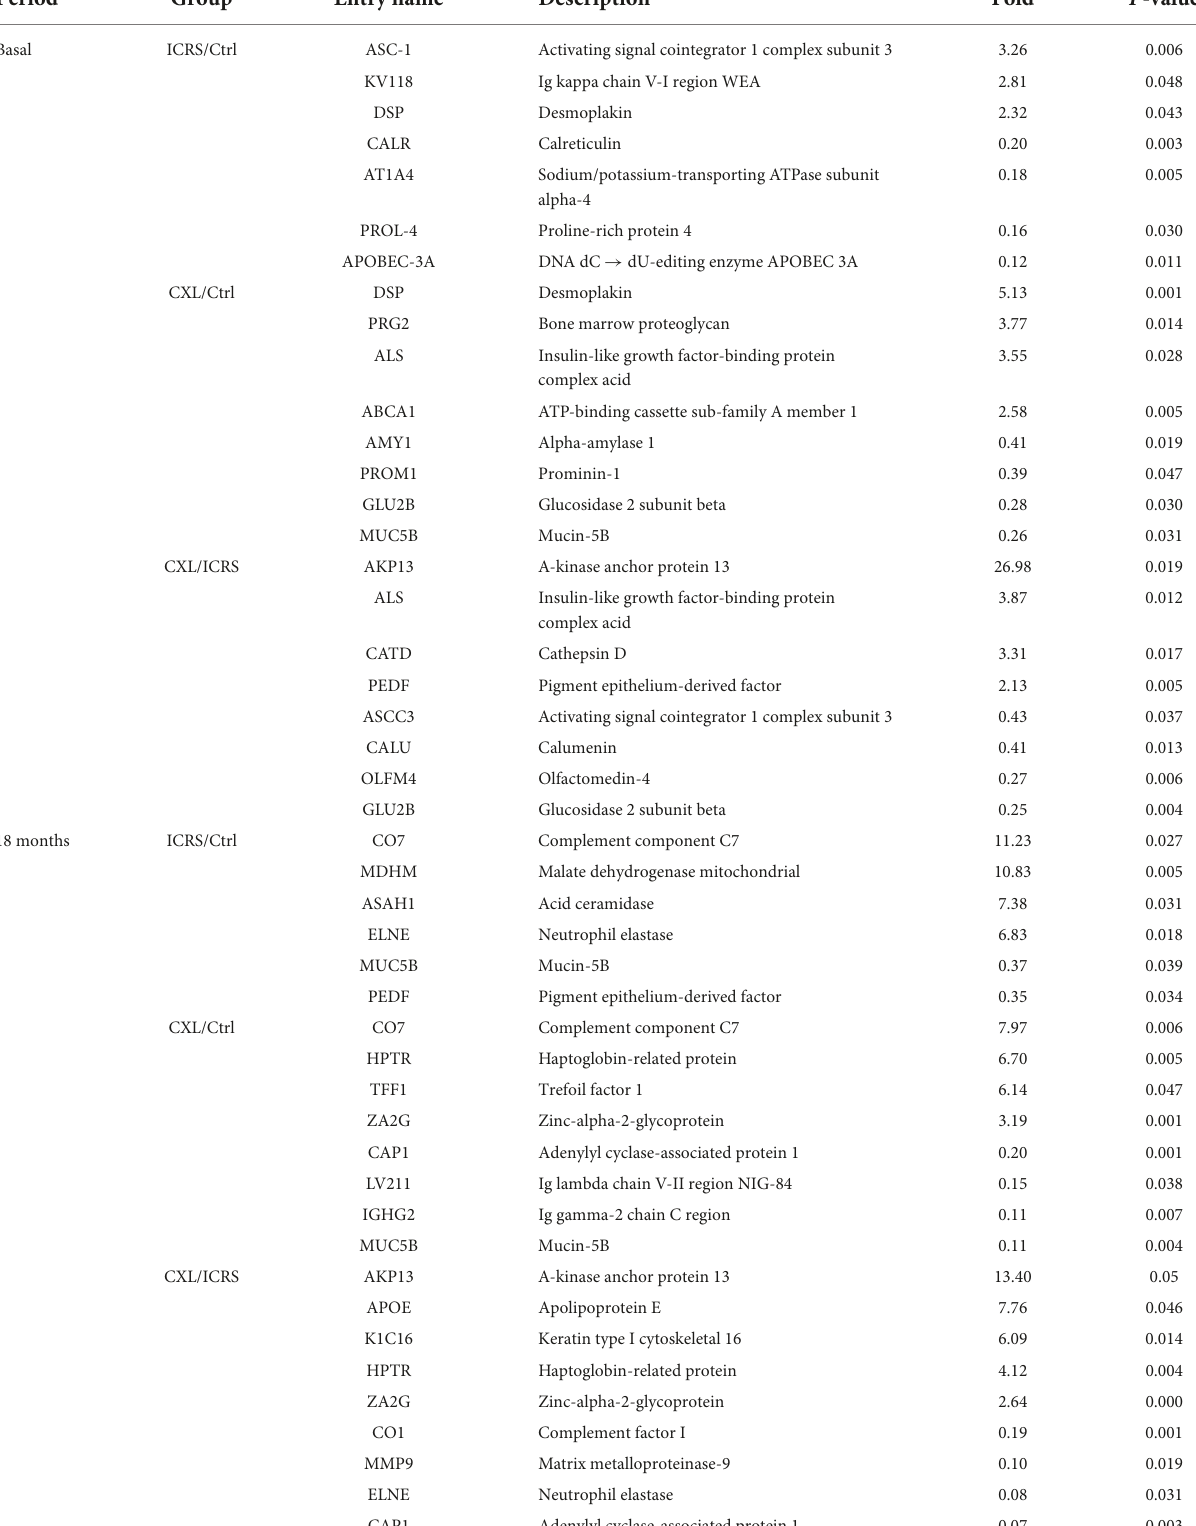
TABLE 2 Changes between surgical techniques and control group by time period and expression type.